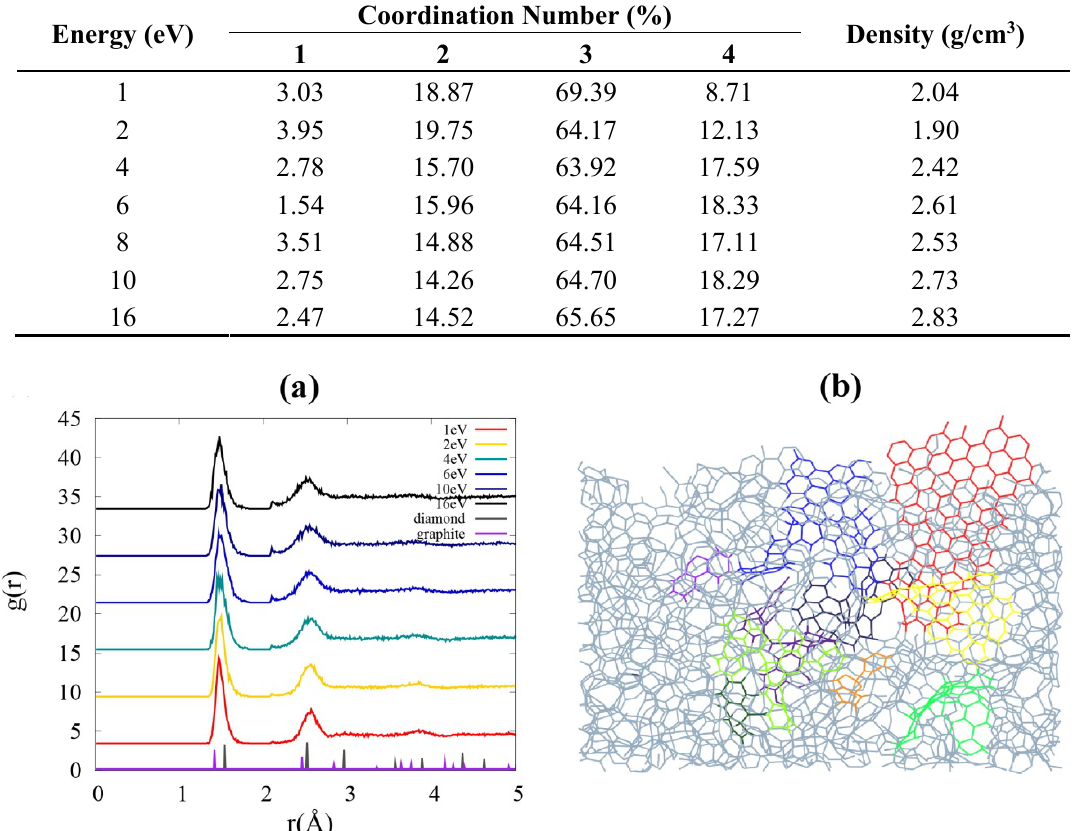
Table 1. Energy dependent bond population and density of the deposited films. In this incident energy range, sp 2 hybridization with a coordination number equal to 2 is always dominant, whereas the sp 3 population increases and sp 1 decreases with increasing energy.